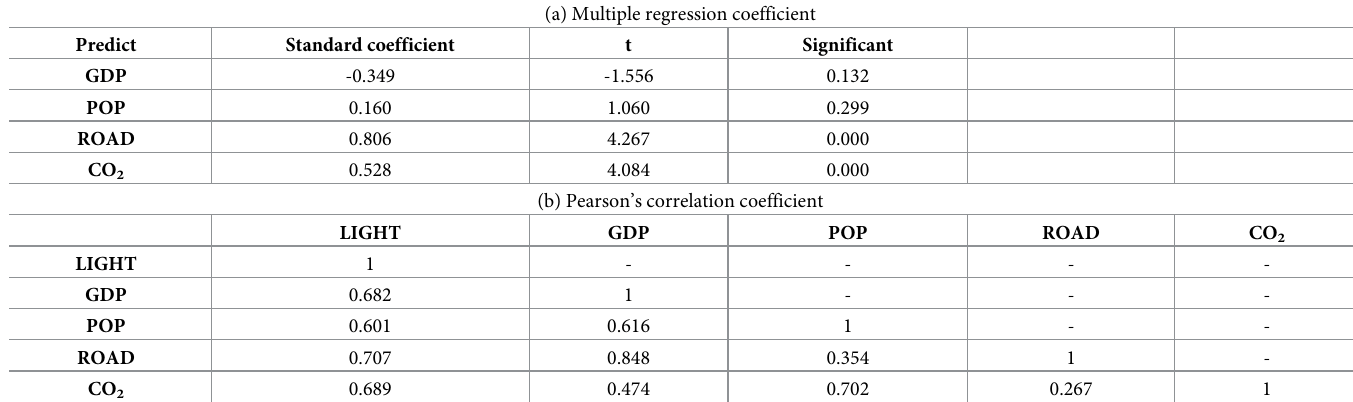
Table 8. Multiple regression coefficient table and Pearson correlation coefficient table of NTL density in Indian state after excluding two megacities.